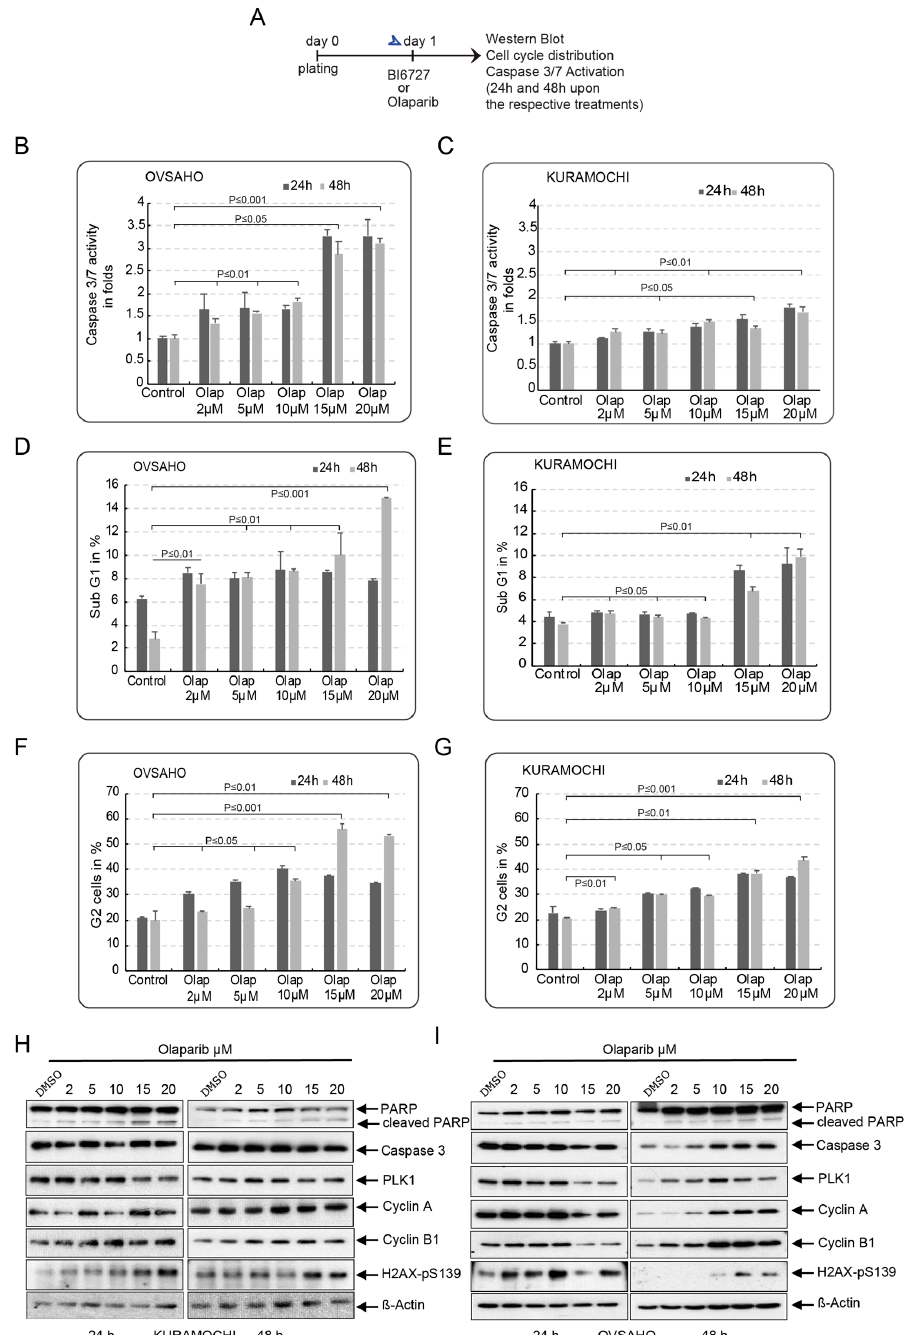
Figure 1. KRAS amplification mediates resistance to PARPi in HGSOC cells with BRCA2 deficiency . ( A )—Treatment schedule: KURAMOCHI and OVSAHO cells were treated with increasing concentrations of the PARP inhibitor Olaparib, 2 µM to 20 µM. Cells were harvested after 24 h and 48 h,